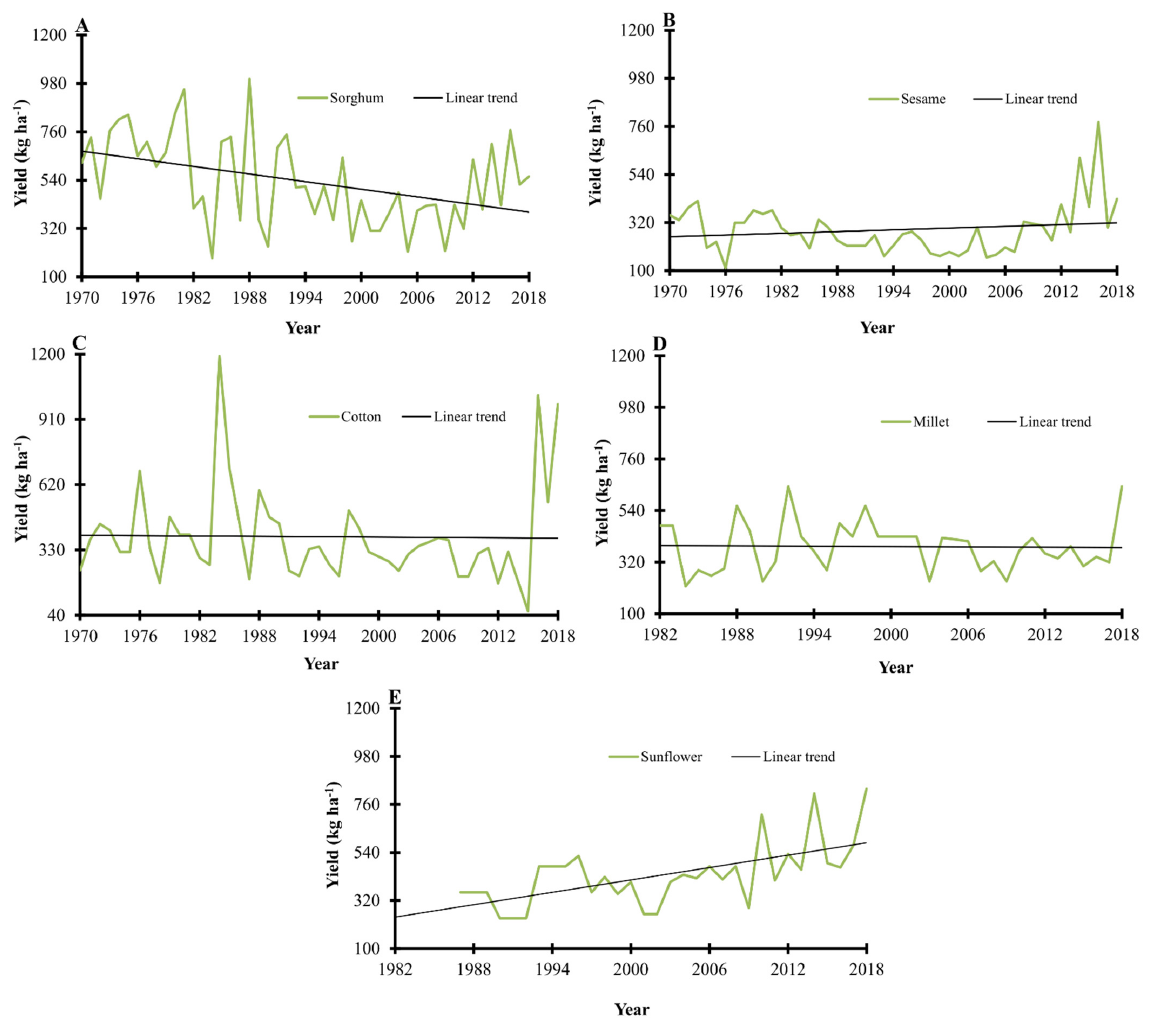
Figure 5. Annual crop yield trends for the major crops grown in Gedaref State, Sudan from 1970 – 2018, ( A ): sorghum, ( B ): sesame ( C ): cotton, ( D ): millet and ( E ): sunflower yield trends.